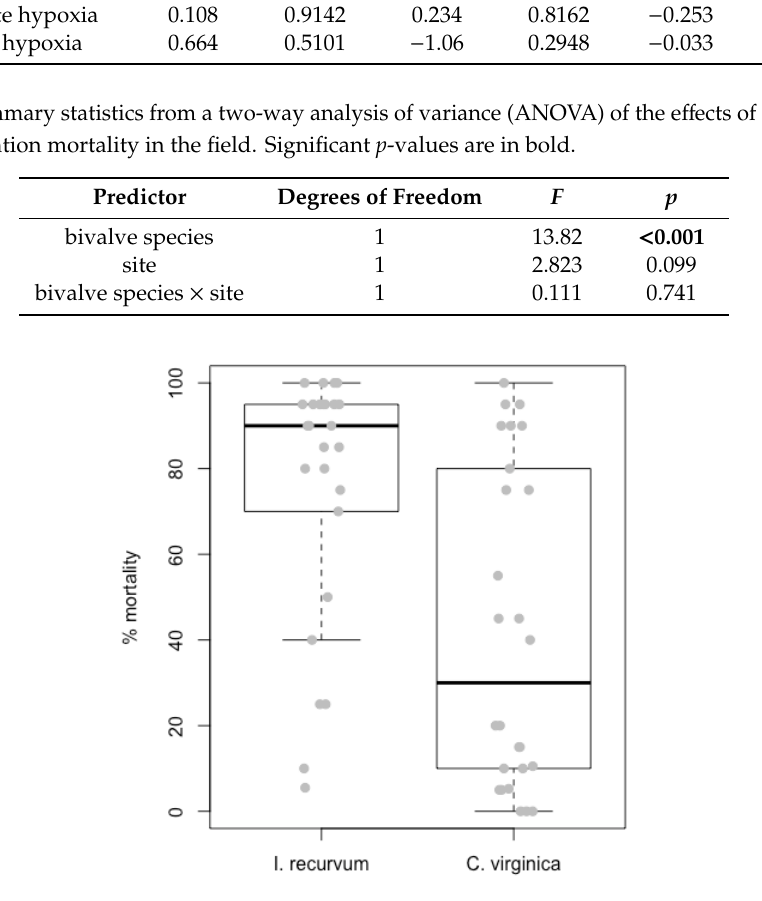
Figure 3. Proportion of prey consumed in field experiment trials by species. Bold black bars indicate the median value, box ends and whiskers indicate the interquartile and full ranges of the data, and gray points indicate data values.